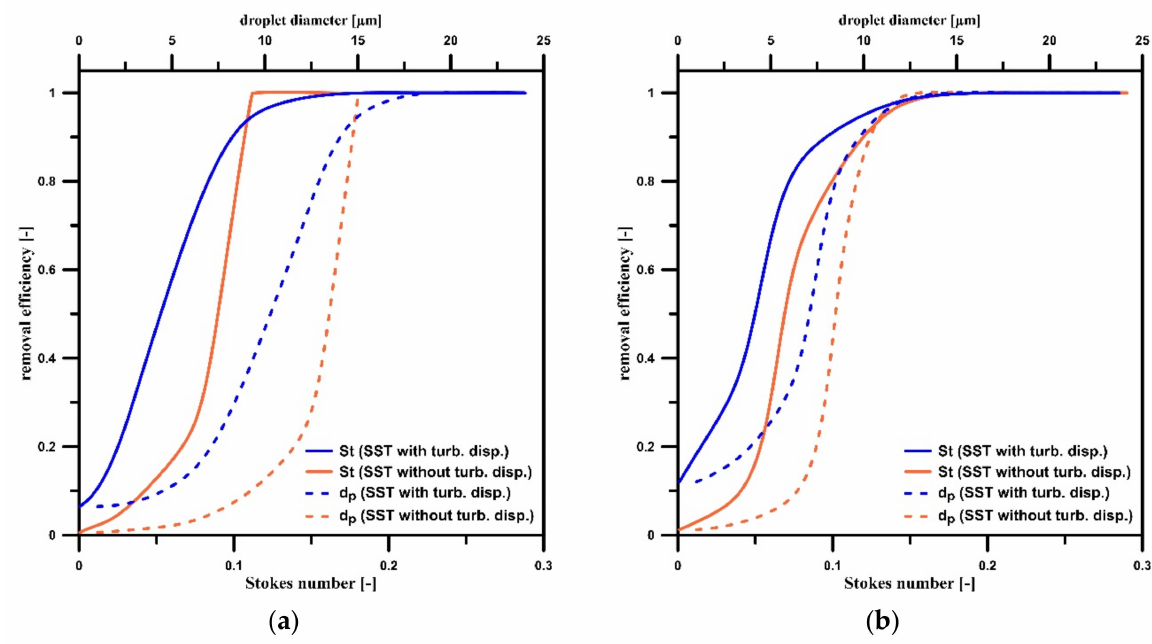
Figure 7. Comparison of calculated Stokes numbers with results obtained with the SST model with and without using turbulent dispersion with experimental data for geometry B_10_0 with inlet velocity: ( a ) 2 m s − 1 ; ( b ) 4 m s − 1